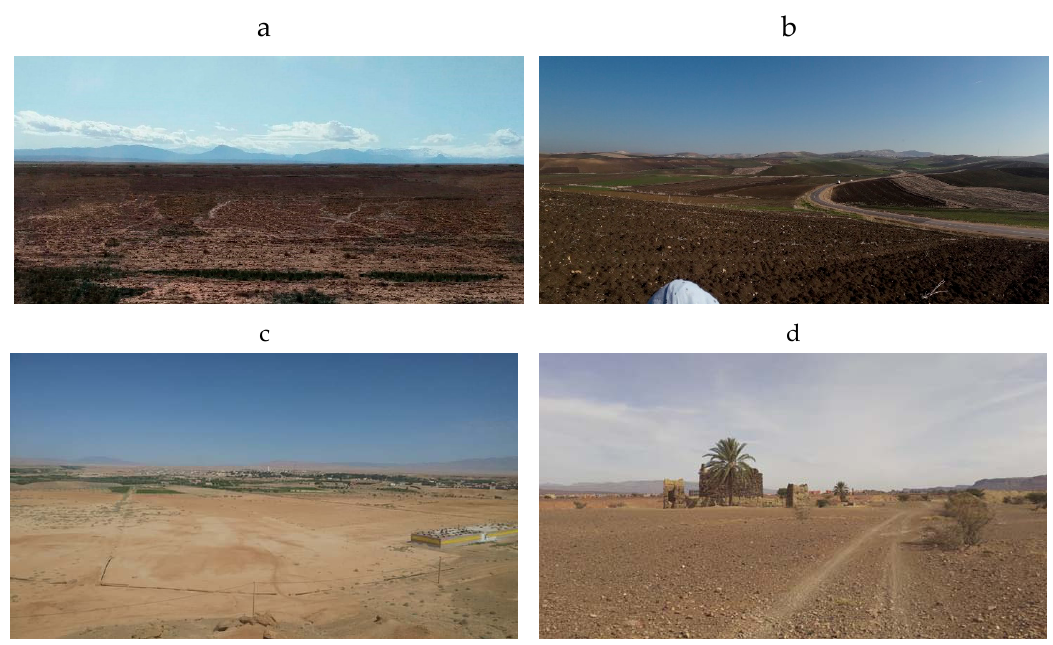
Figure 12. Observation of ( a ) the Guercif plain with the eastern relief of the folded Middle Atlas in the background, ( b ) Pre-rifaine zone in the western part of the External Prerif, ( c ) Missour Plain in the southwestern part of the Middle Atlas, and ( d ) Alluvial plain in the Zagora region Southeast of the Central Anti-Atlas.